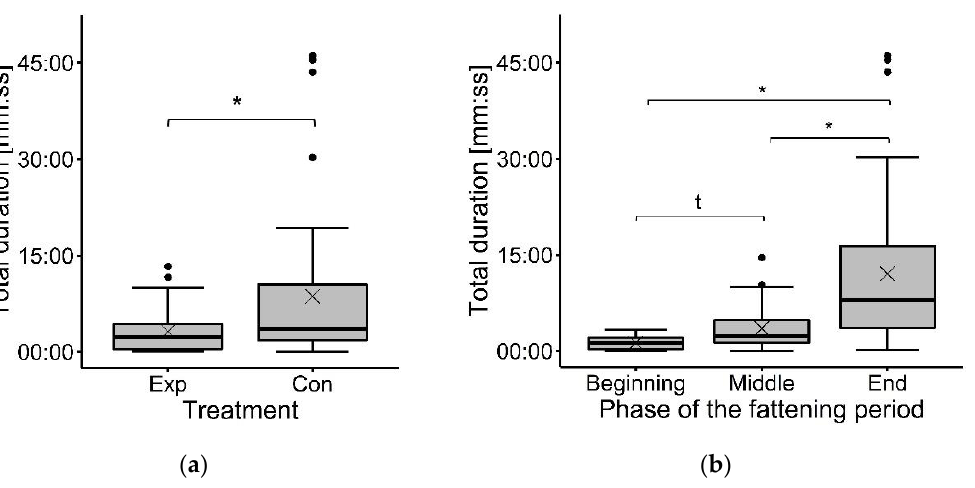
Figure 4. Total time focal animals spent in the observed area: ( a ) in the experimental group (Exp) and the control group (Con); ( b ) in the different phases of the fattening period. Results are presented as boxplots (data range, median, and lower and upper quartile; outliers are included in the graph as dots and means as a cross). * Significant difference at p < 0.05, t tendency at p < 0.1.